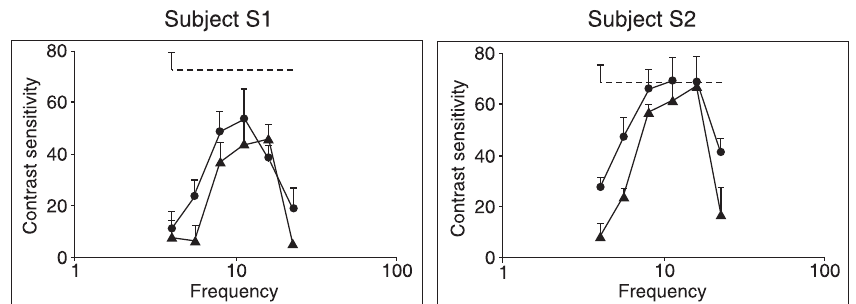
Figure 3. Face regions analyzed by the global and local Fourier-Bessel models. Regions outside the face area, but in the radius range, were cropped only in this illustration.